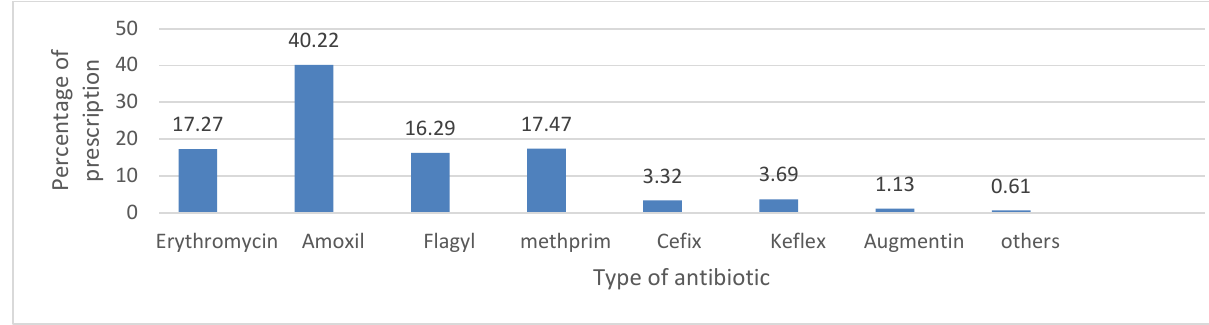
Figure 1: Single antibiotic used in outpatient department (Total 4070).